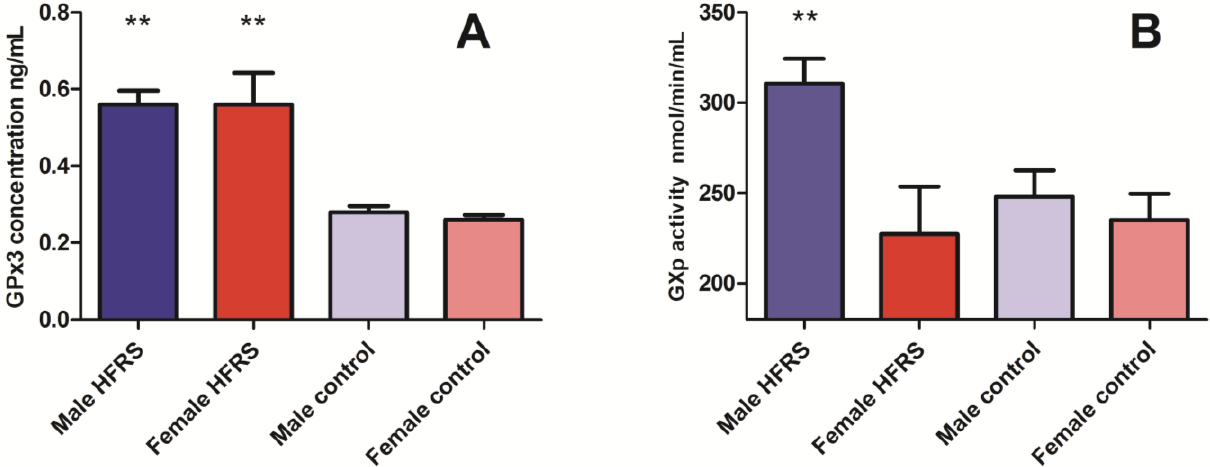
Figure 3. Glutathione peroxidase (GPx3) concentrations ( A ) and GPx activity ( B ) in HFRS patients and healthy controls. Asterisks (**) represent a p value smaller than 0.01 ( p < 0.01). GPx3 levels ( A ), the major binding protein of selenium in humans, were increased in acute HFRS patients compared to controls; Furthermore, GPx enzyme activity levels; ( B ) in nmol/min/mL were statistically significantly higher in male HFRS patients compared to